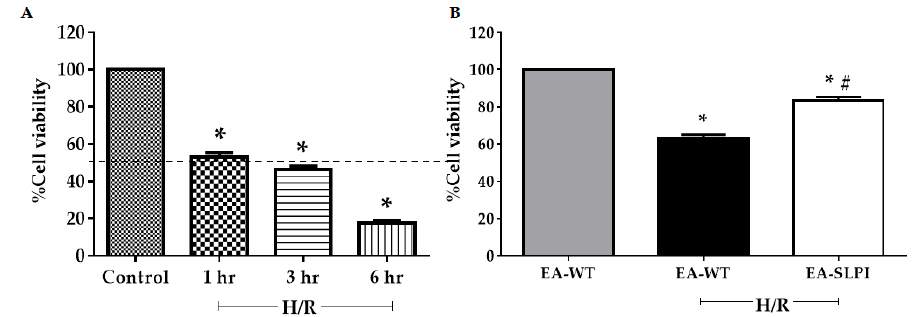
Figure 4. Determination of SLPI-overexpressing EA.hy926 cells in hypoxia/reoxygenation (H/R). ( A ) EA.hy926 cells were subjected to 1, 3, and 6 h hypoxia followed by 3 h of reoxygenation; ( B ) Wild-type (EA-WT) and SLPI-overexpressing (EA-SLPI) EA.hy926 cells were exposed to 1 h of hypoxia followed by 3 h reoxygenation, and the cell viability was determined by MTT. Each bar represents the mean ± SEM. * p < 0.05 vs. non-H / R-treated group (ANOVA), # p < 0.05 vs. H / R-treated group (ANOVA, n =